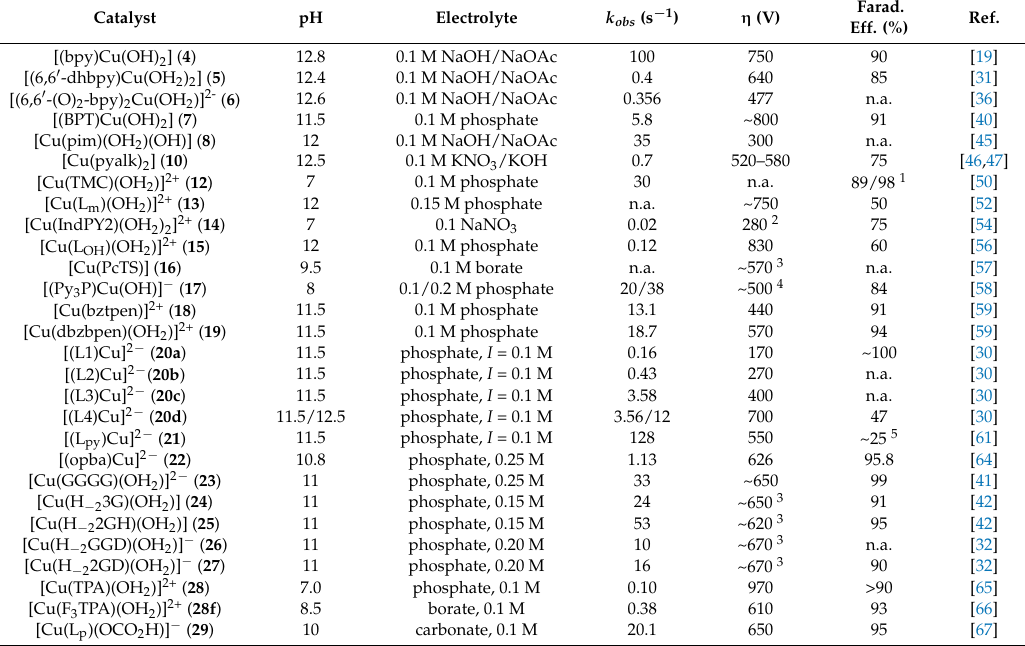
Table 2. Selected kinetic, electrochemical data and reaction conditions of single Cu-site water oxidation catalysts (for ligand names see the corresponding